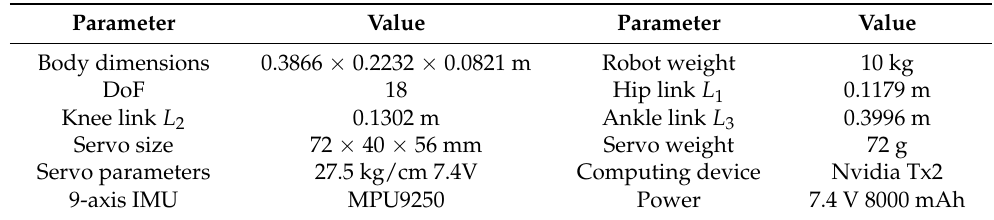
Figure 2. The rotation angles of the three active joints relative to the initial position are denoted as θ 1 , θ 2 and θ 3 . The lengths of the three links are recorded as L 1 , L 2 and L 3 . The distance from the center of the body to the hip joint of the Leg i is r i ( i = 1, ··· , 6). A body coordinate frame { B } is located in the center of the body. The z-axis of the joint coordinate frame { OJ ij } ( j = 1, 2, 3) coincides with the joint rotation axis. Additionally, the foot tip coordinate frame is denoted as { OFi }. Table 1. VkHex details and